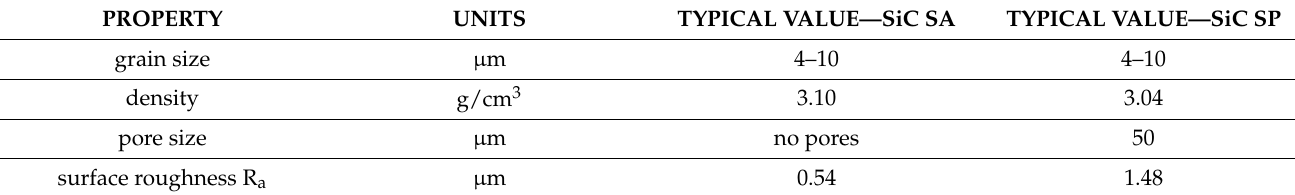
Table 2. Grain size, density, pore size and surface roughness values for the Hexoloy ® silicon carbides SA and SP. PROPERTY UNITS TYPICAL VALUE—SiC SA TYPICAL VALUE—SiC SP grain size µ m 4–10 density g/cm 3 3.10 pore size µ m no pores 50 surface roughness R a µ m 0.54